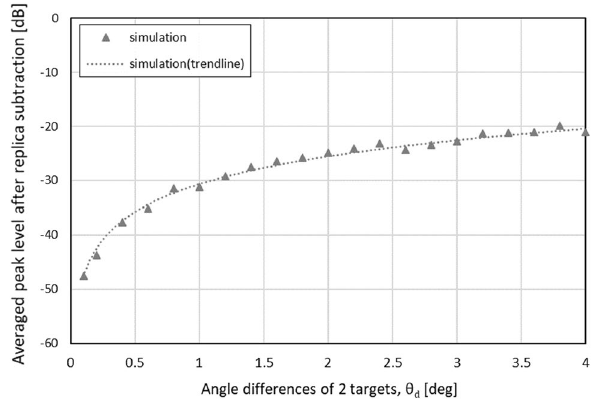
Figure 6. Computationally obtained relationship between average residual levels and angle differences.